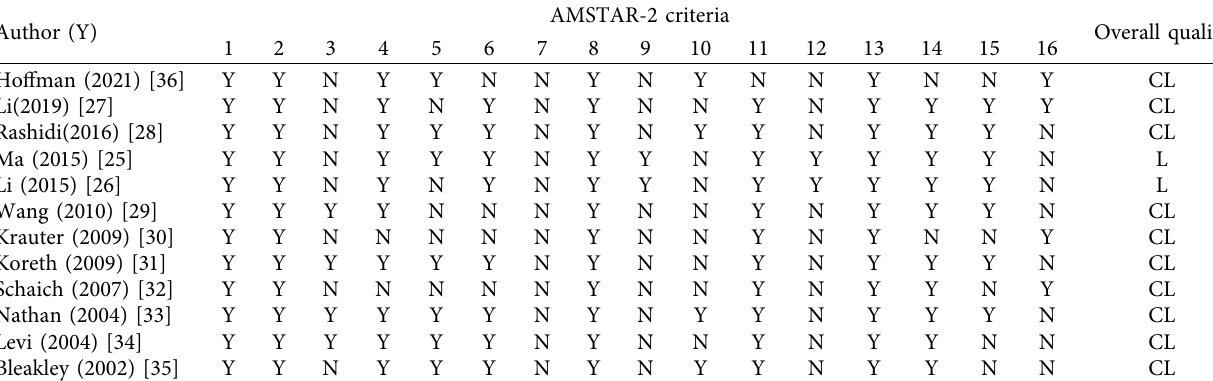
Table 2: Quality of the included reviews as rated on the AMSTAR-2